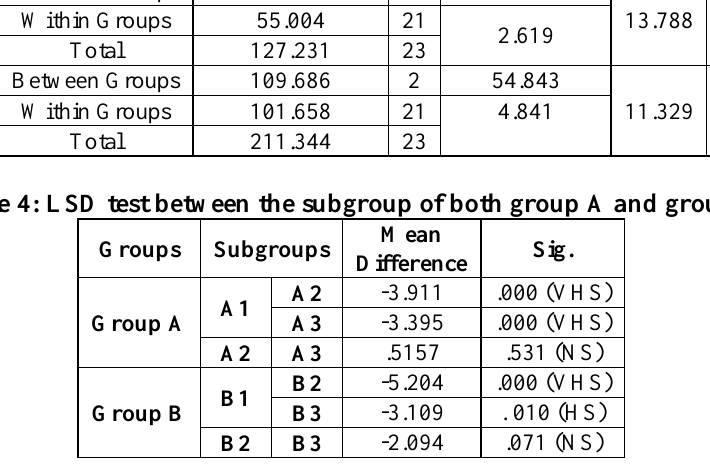
Table 3: ANOVA test for both group A and group B Group